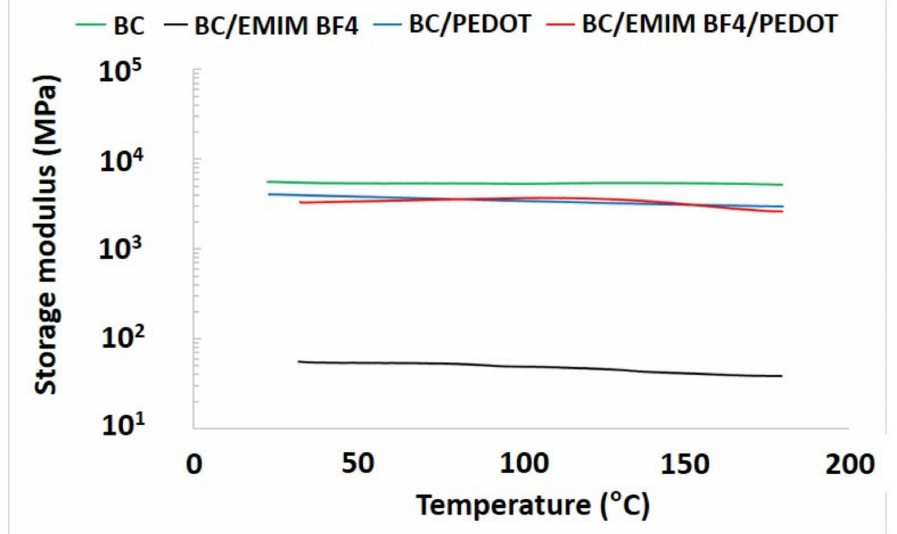
Figure 7. DMA of samples BC, BC/EMIMBF4, BC/PEDOT, and BC/EMIM BF4/PEDOT. The values of the storage modulus, in megapascals, are reported as a function of the working